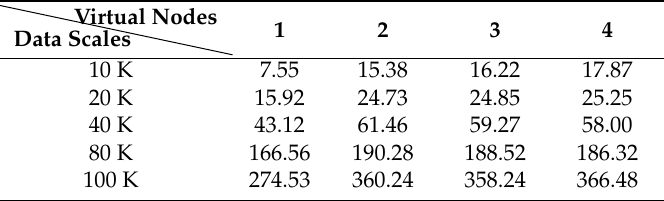
Table 9. Running time of serial and parallel DBSCAN algorithms based on Docker Spark platform (s).